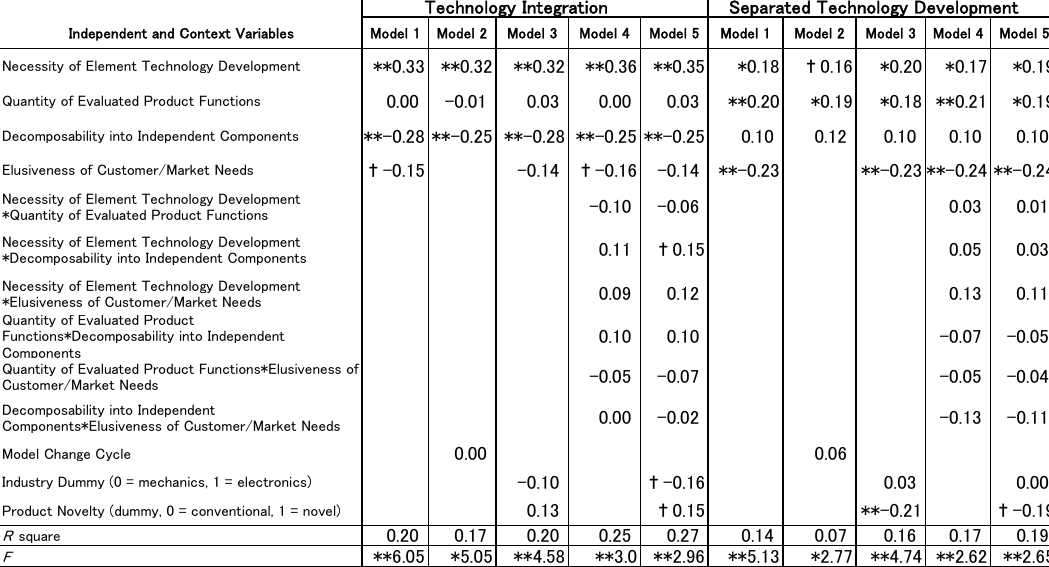
Table 1. Results of multiple regression analysis Technology Integration Separated Technology